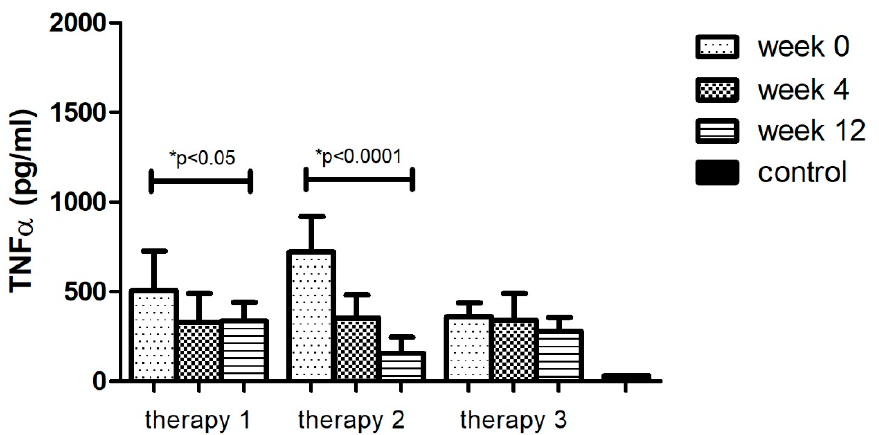
Figure 3. TNF α level (pg/mL) before (week 0) and during (week 4, week 12) therapy with: MTX (therapy 1, n = 20), anti-TNF α (therapy 2, n = 20), anti-IL-17A (therapy 3, n = 10) in patients with plaque psoriasis compared with a control consisting of healthy volunteers ( n = 16). * indicates a statistically significant difference ( p < 0.05) between weeks: 0 and 12. Table 11. TNF α level (pg/mL) between treatments with: MTX (therapy 1, n = 20), anti-TNF α (therapy 2, n = 20) and anti-IL-17A (therapy 3, n = 10) in patients with plaque psoriasis at three measurement points (week 0, week 4, week 12). * indicates a statistically significant difference ( p < 0.05).